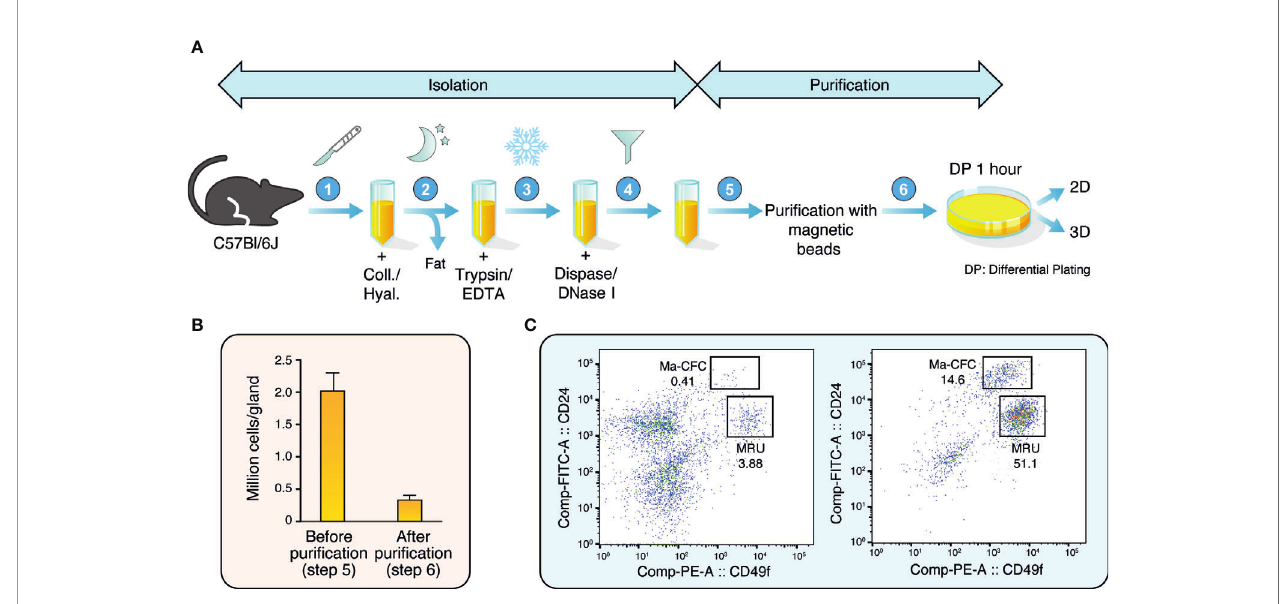
FIGURE 1 | Isolation and puri fi cation of mouse mammary epithelial cells. (A) Schematic representation of the isolation and puri fi cation protocols to obtain mouse mammary epithelial cells. (B) Number of mammary epithelial cells obtained before and after isolation and puri fi cation (between steps 5 and 6 in A). Results are shown as mean ± SEM of 11 independent experiments. (C) Distribution of mammary epithelial cells before (left) and after (right) puri fi cation according to their CD24 and CD49f expression. The mammary colony-forming cell (Ma-CFC) fraction was de fi ned as the CD24 High ; CD49f Low and the mammary repopulating units (MRU) fraction as the CD24 Low ; CD49f High . Numbers are percentages. One representative experiment out of three independent experiments is